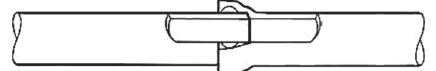
Figure 11: Cracks observed in the joint between a restrained weak pipe and an unrestrained one [11].